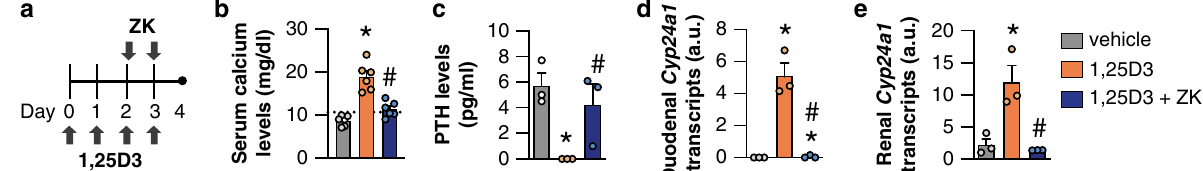
Fig. 6 ZK therapeutic effect in mice. a Schematic representation of 1,25D3 and ZK administration to mice. Serum calcium ( b ) and PTH ( c ) levels, and duodenal ( d ) and renal ( e ) relative Cyp24a1 transcript levels, 24 h after the last administration of vehicle, 1 µ g/kg 1,25D3, or 1 µ g/kg 1,25D3 and 1 µ g/kg ZK. Dashed line in ( b ) represents the maximal normo-calcemic concentration (10.7 mg/dL). b n = 6 mice/condition. c – e n = 3 mice/condition. Data are represented as mean + s.e.m. * p < 0.05 vs. vehicle, # p < 0.05 vs. 1,25D3, one-way ANOVA with Tukey post-hoc test. The exact signi fi cant p -values are provided in Supplementary Table